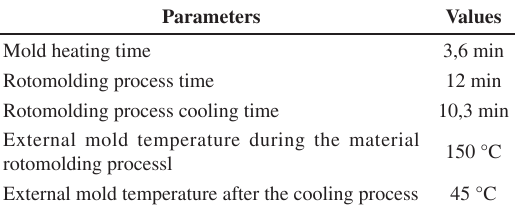
Figure 1. Schematically, the cylindrical container rotomolded and the specimen cut from the Table 2. Rotomolding process parameters.